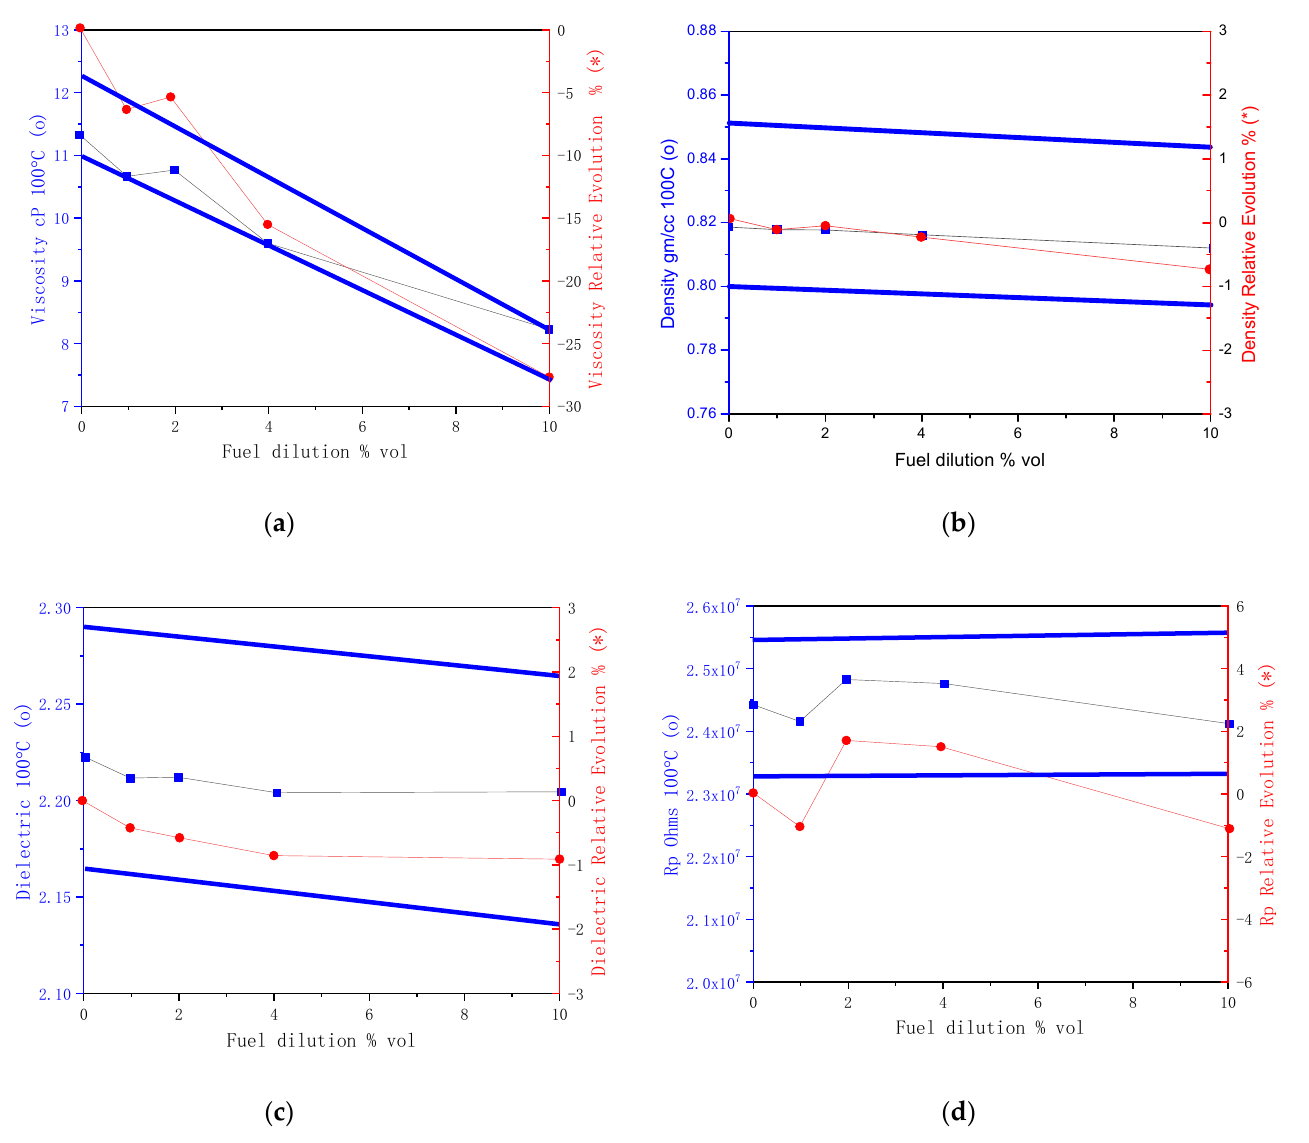
Figure 15. Fuel dilution in engine oil (15W40): ( a ) viscosity; ( b ) density; ( c ) dielectric; and ( d ) Rp. Resistivity does not show any consequent change. Density and dielectric are linearly